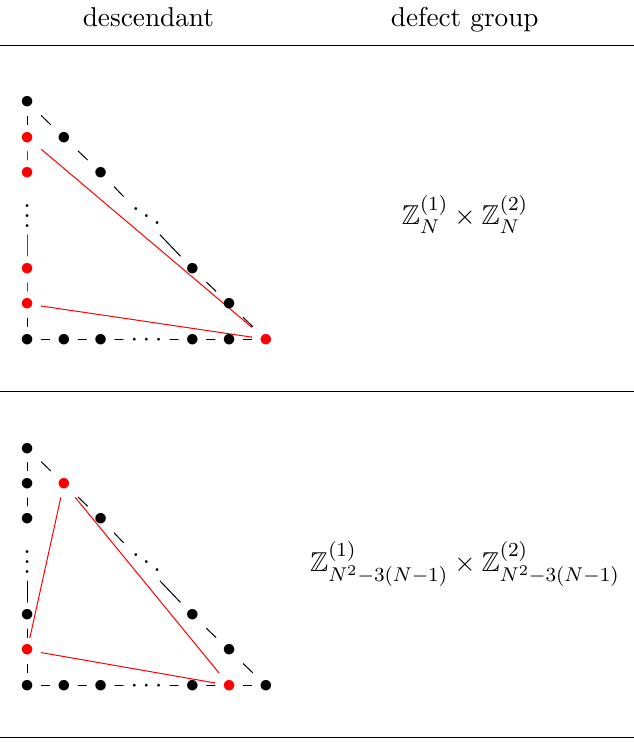
Figure 8 . Examples of T N descendants [105] with a nontrivial center symmetry. The one on the bottom is known as the B N theory